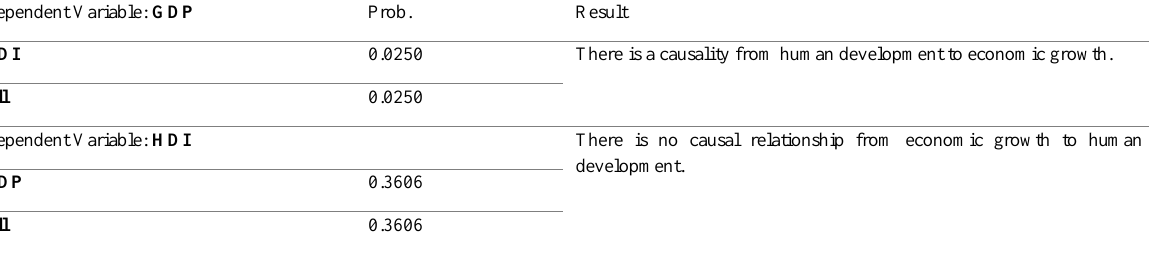
Table 9: Granger Causality